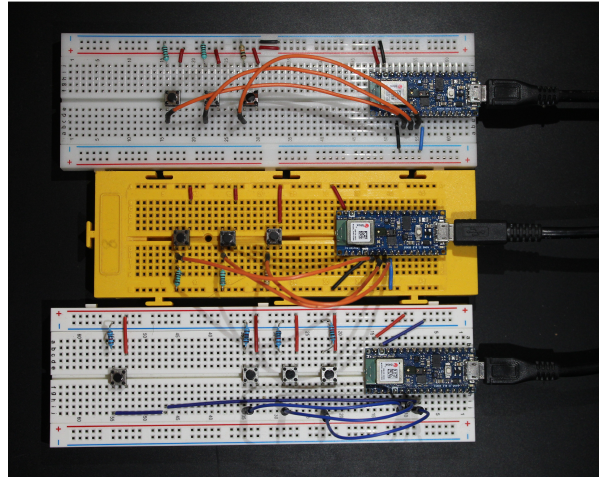
Figure 1. The Arduino Nano 33 BLE Sense board and the buttons on a breadboard to control the training and inference process. The hardware for three federated learning clients is